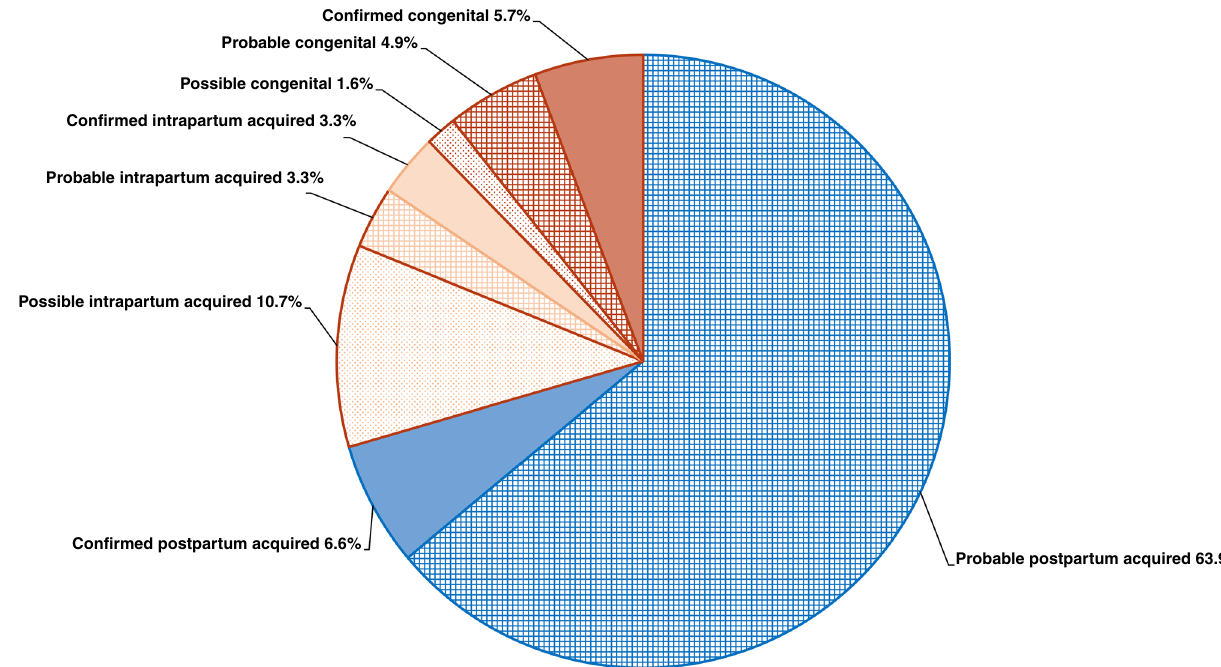
Fig. 2 Classi fi cation of neonatal SARS-CoV-2 infections according to the de fi nition of maternal, fetal, and neonatal SARS-CoV-2 infections. Classi fi cation is based on a system including several virological tests (on placental tissues, amniotic fl uid, cord and newborn blood or nasopharyngeal swabs), as well as the presence of clinical manifestations 16 . Cases are divided into: (1) congenital infections, (2) intrapartum acquired infections, or (3) postpartum acquired infections and into fi ve mutually exclusive categories of the likelihood of infection: “ con fi rmed ” , “ probable ” , “ possible ” , “ unlikely ” , and “ not infected ” . Classi fi cation was applied to 122 cases (for 54 neonates, data needed to classify the infection were missing despite repeated requests to the authors of the articles). Areas in blue depict the infections con fi rmed or supposed to be environmentally acquired (i.e.: postpartum), while areas in brown depict con fi rmed or supposed to be vertically (either intrapartum or congenitally) transmitted infections; numbers represent the %.